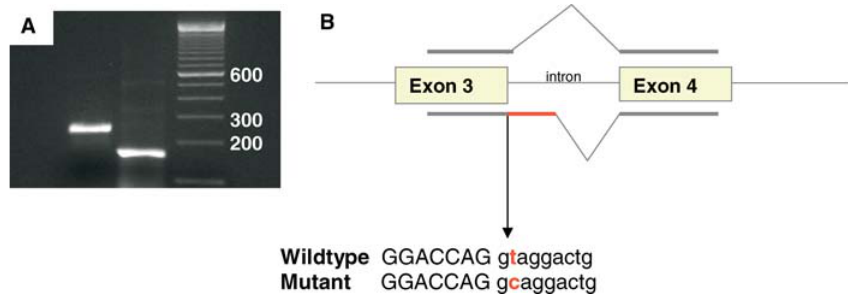
Figure 2. The ENU-Induced lil Mutation in Fog2 is a Splice Site Mutation (A) RT-PCR revealed a lengthened transcript in mice with the lil phenotype: the first band is a lil mouse, and the second band is a control mouse. (B) Sequencing Fog2 revealed a splice site mutation that causes the insertion of 85 bp of intronic sequence in the mutant mouse. This results in a premature stop codon prior to zinc finger transcription. DOI: 10.1371/journal.pgen.0010010.g002 PLoS Genetics |